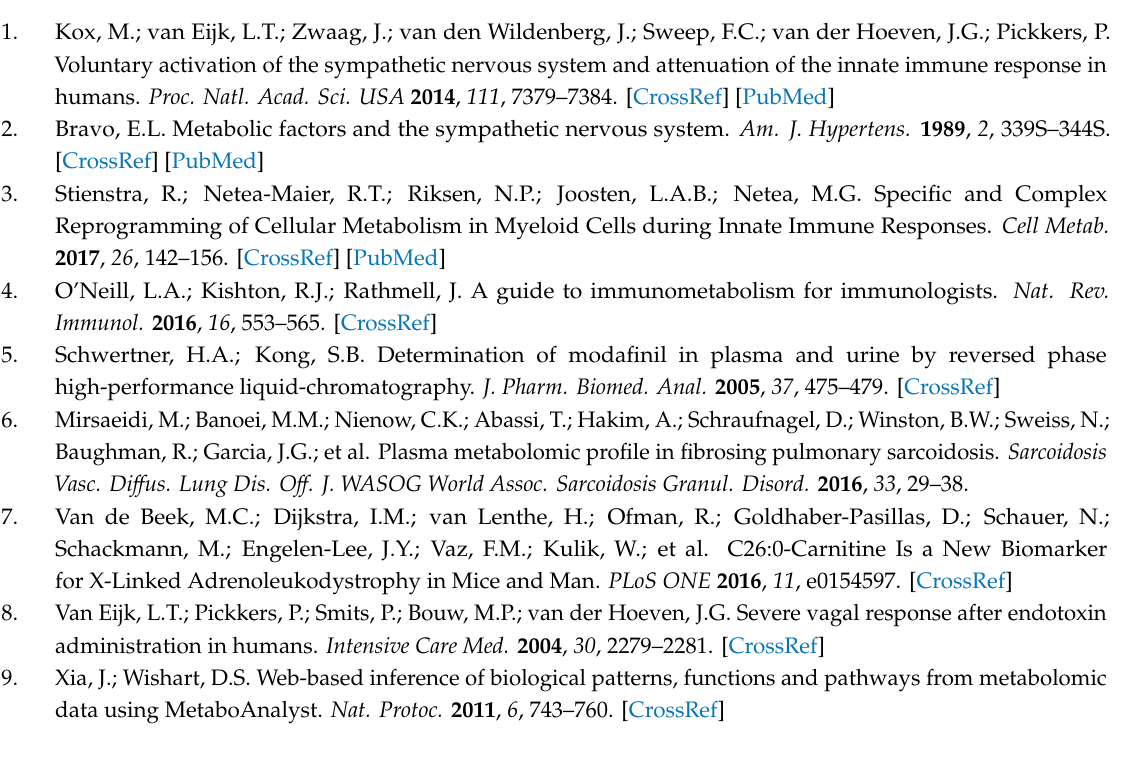
Figure S1: Enriched pathways after LPS administration, Figure S2: Comparison of plasma lactate concentrations measured by LC-MS and a point-of-care analyzer. Table S1: Subject characteristics, Table S2: Baseline, peak, and area under curve (AUC) plasma cytokine responses in control and trained groups, Table S3: Changes in plasma metabolite levels during endotoxemia in the control group. Table S4: Changes in plasma metabolite levels during endotoxemia in the trained